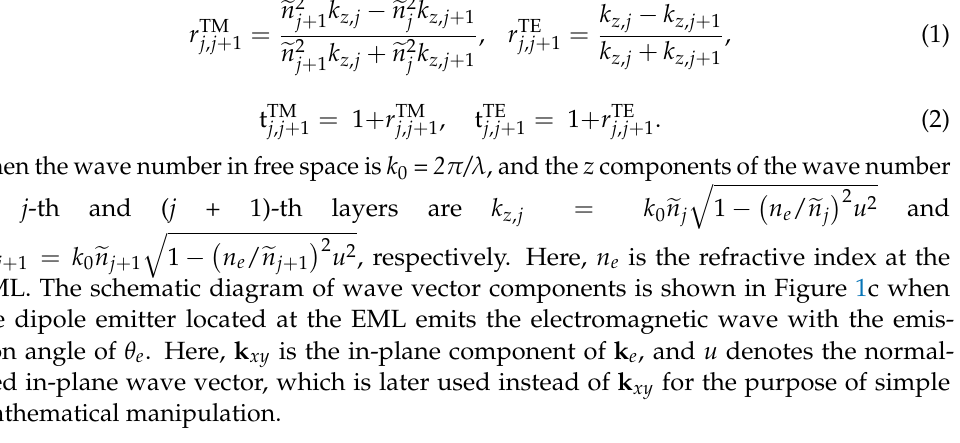
the reflection and transmission coefficients from the EML to the upper (lower) ambient ( TM ) ( TM ) layer, where the +( − ) sign in r TE and t TE denotes the upper (lower) direction. e , +( − ) e , +( − ) Figure 1b shows the polarization-dependent sign convention of electric and magnetic field amplitudes on transmission and reflection based on the Verdet convention, where polarization-dependent Fresnel reflection and transmission coefficients from layer j to j + 1 are expressed as [18]